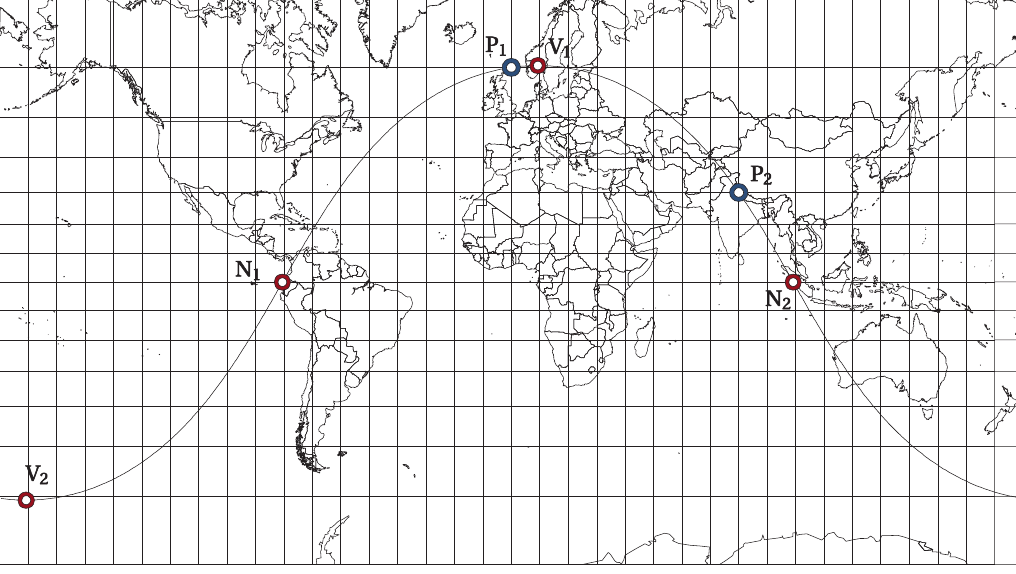
Figure 4. First normal section in a Mercator chart. The same points of the example in Figure 2 are used. The nodes and vertices of the path are indicated. The flattening of the ellipsoid is the original of GRS80. The path is closed when one or more full turns of the ellipsoid are